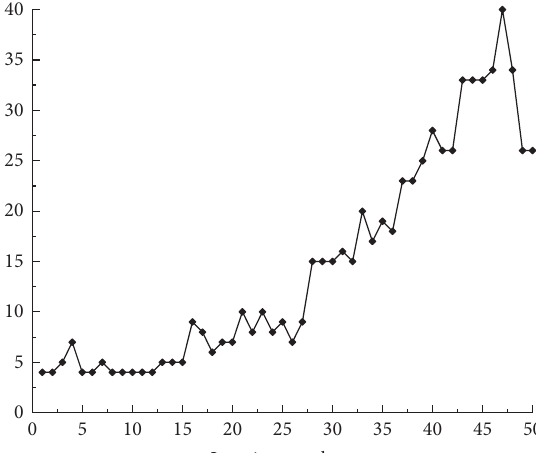
Figure 2: Data feature set